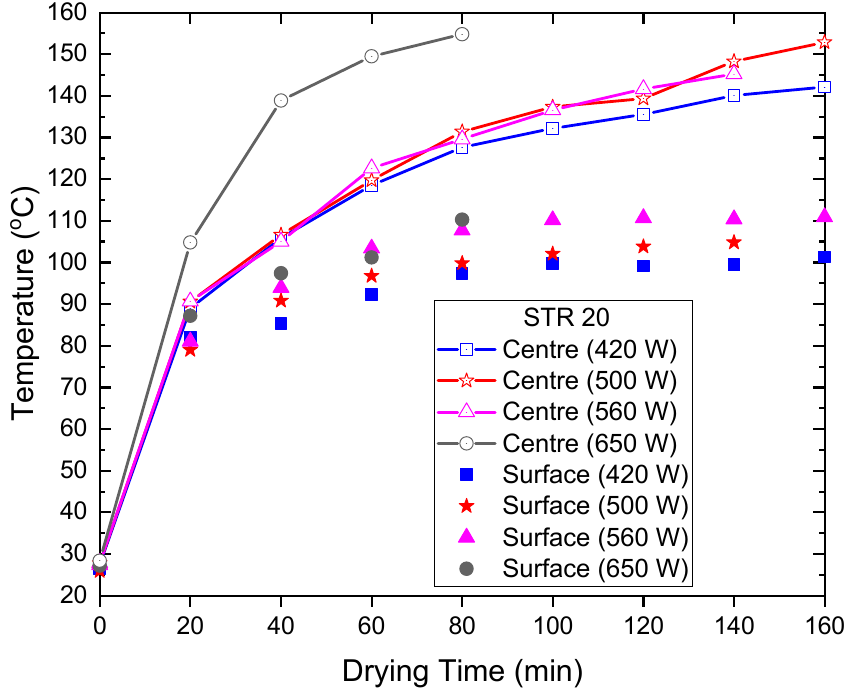
Figure 8. The temperature response versus drying time of the STR20 samples at the centre and surface when different microwave power levels were applied.